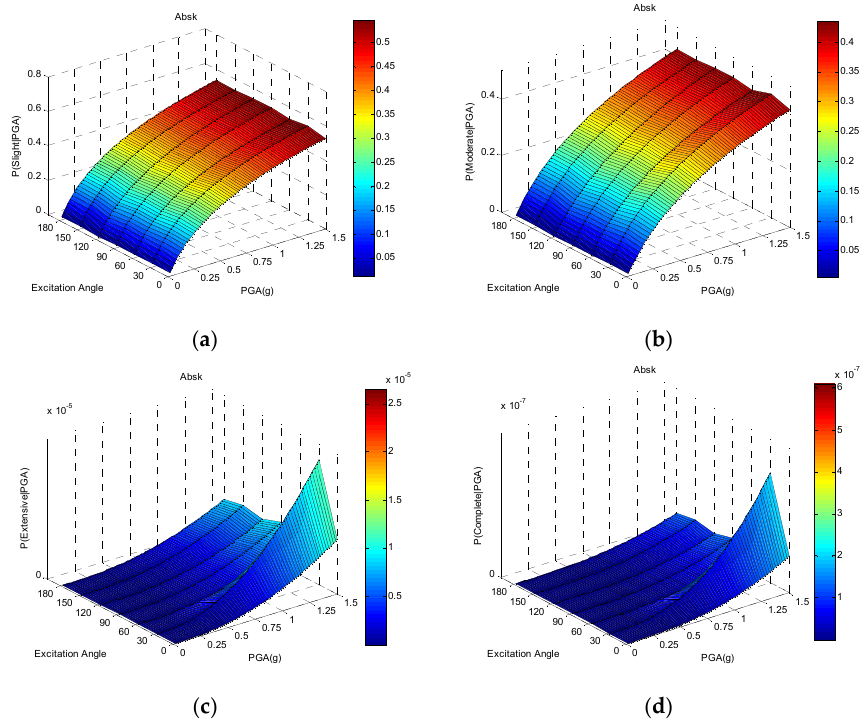
Figure A8. Seismic fragility surfaces of Absk subjected to different excitation angles in the ( a ) slight; ( b ) moderate; ( c ) extensive; and ( d ) complete limit states.